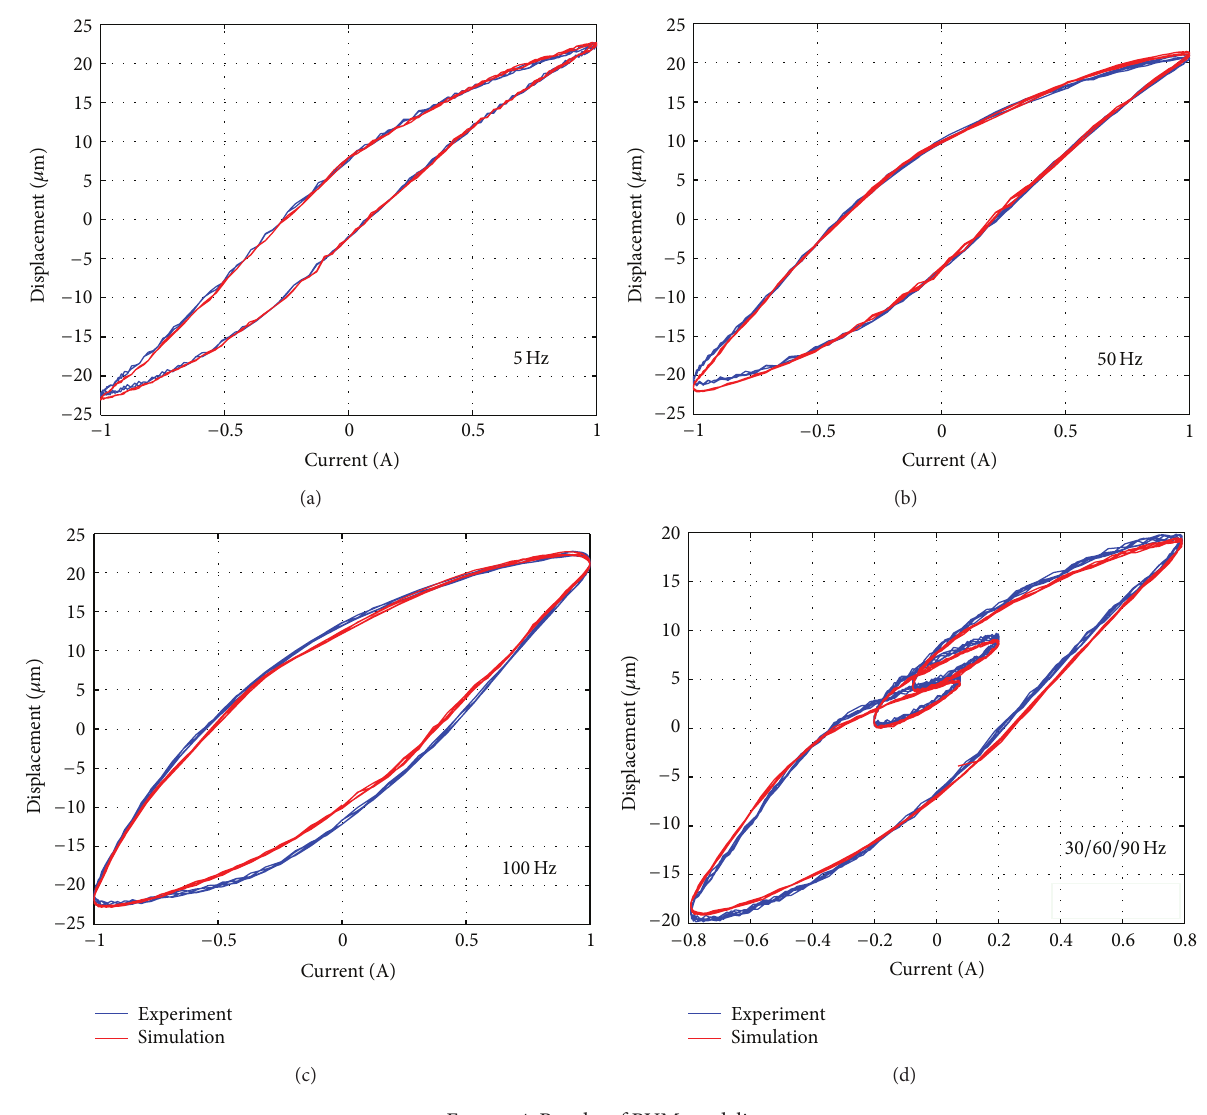
Figure 4: Results of RVM